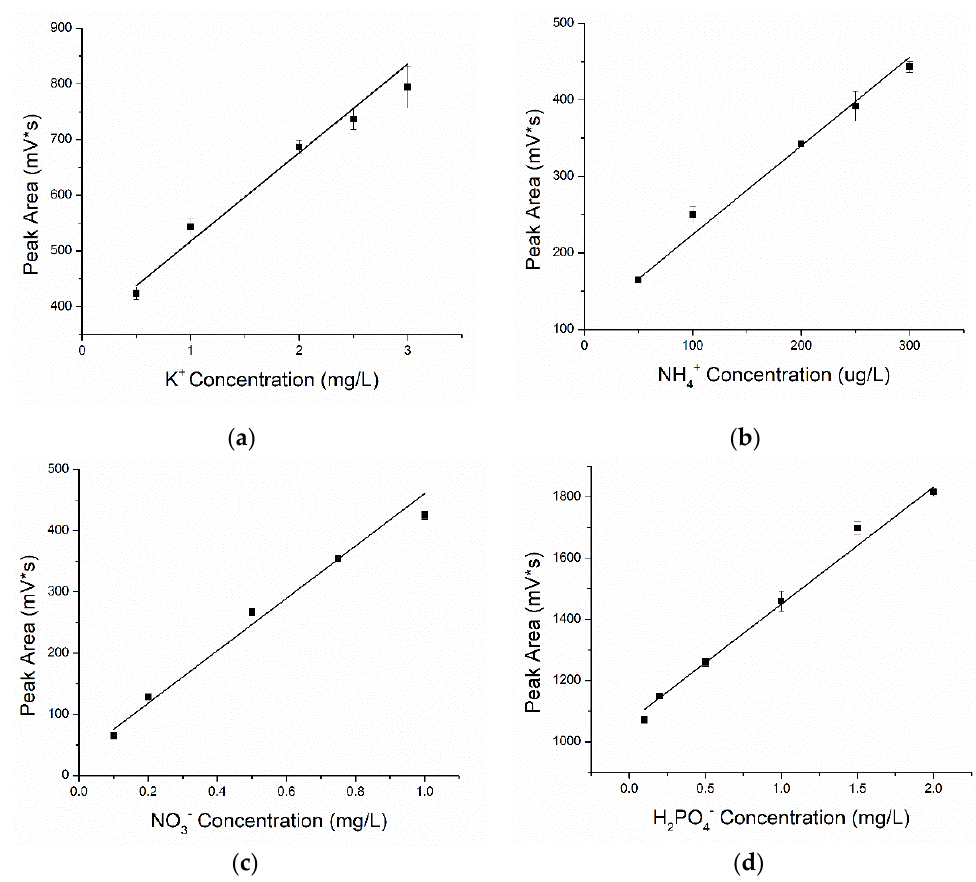
Figure 6. The fit curves for the four kinds of macronutrient ions: ( a ) K + , ( b ) NH 4 + , ( c ) NO 3 − and ( d ) H 2 PO 4 − .